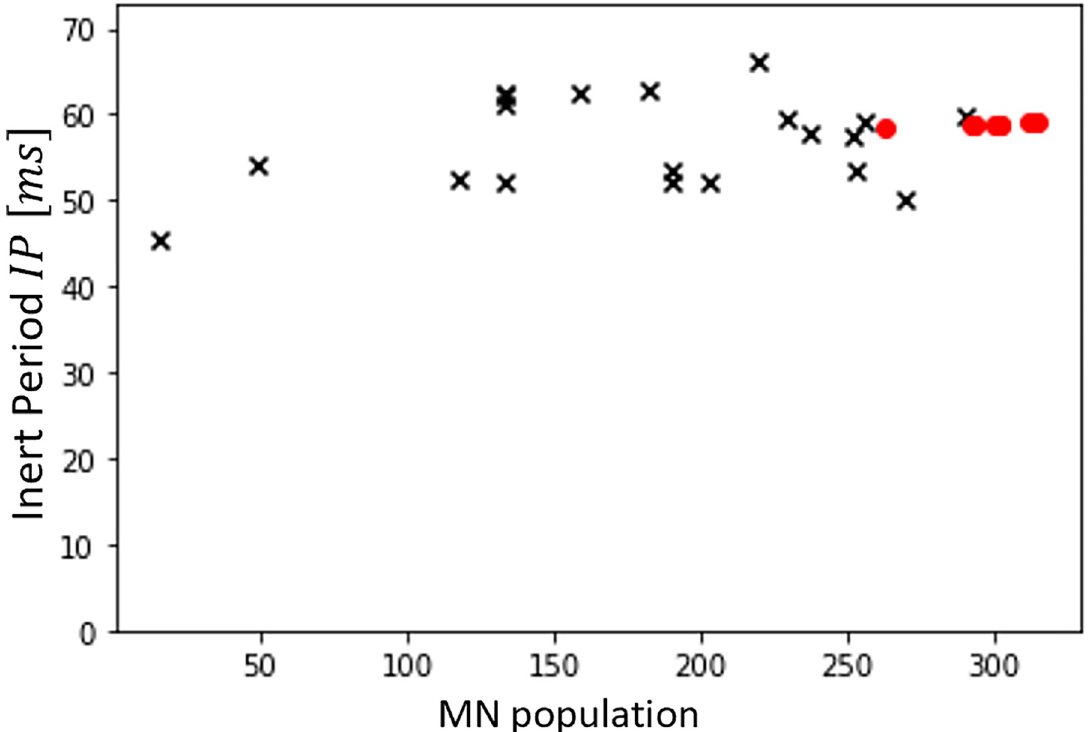
Fig 8. MN Inert Periods (IPs) in ms obtained from the experimental measurements of IDFs in dataset DTA 35 . The twenty lowest- threshold MNs are observed to ‘saturate’ as described in the Methods and their IP (black crosses) is calculated as the inverse of the maximum of the trendline fitting the time-histories of their instantaneous firing frequency. The IPs of the 12 highest-threshold MNs (red dots) are obtained by trendline extrapolation.